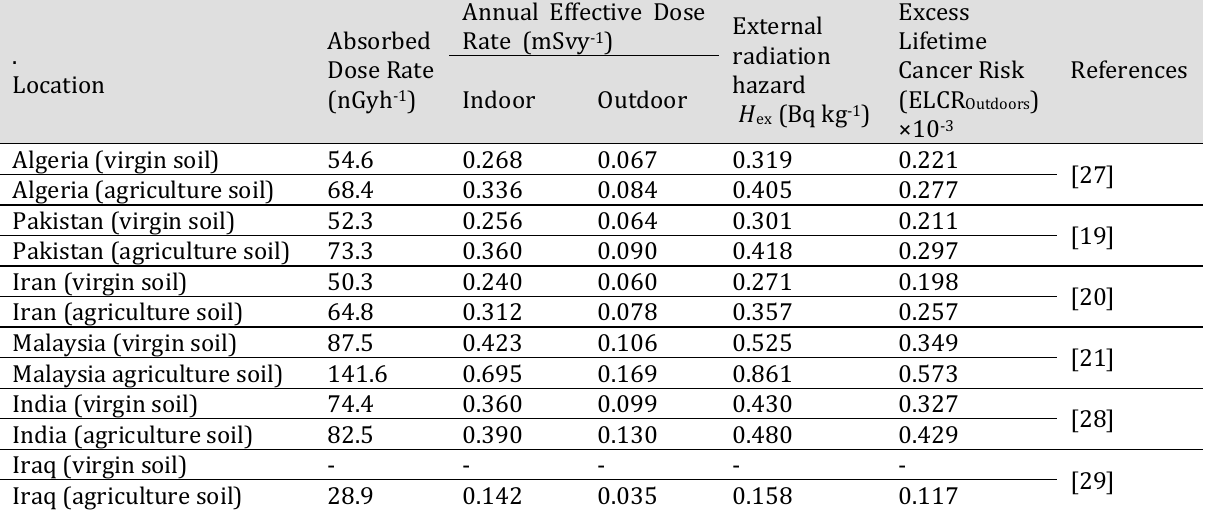
Table 4. The mean values of radiological hazard indices reported at non-fertilized and fertilized soils in similar studies worldwide